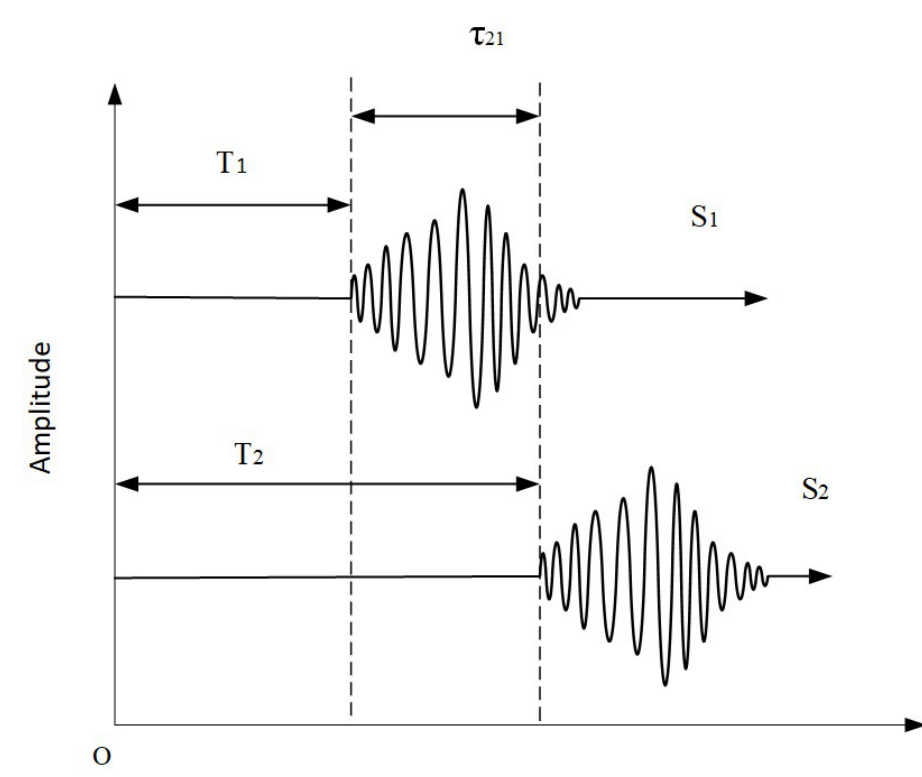
Figure 2. Schematic diagram of the time delay